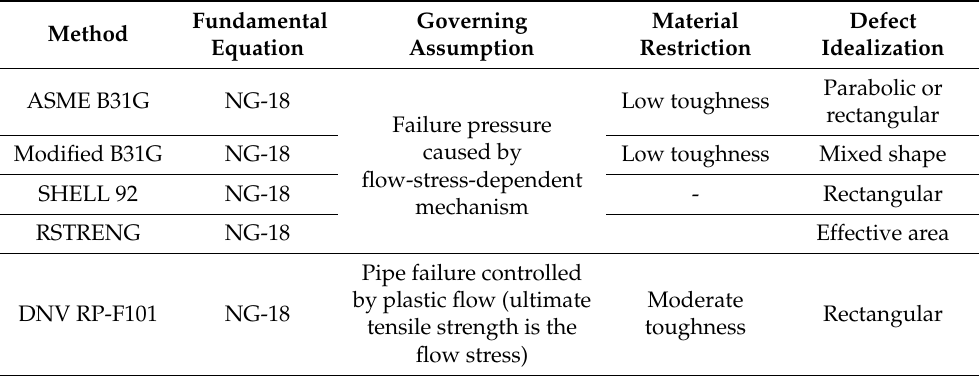
Table 1. Conventional pipe failure pressure assessment codes